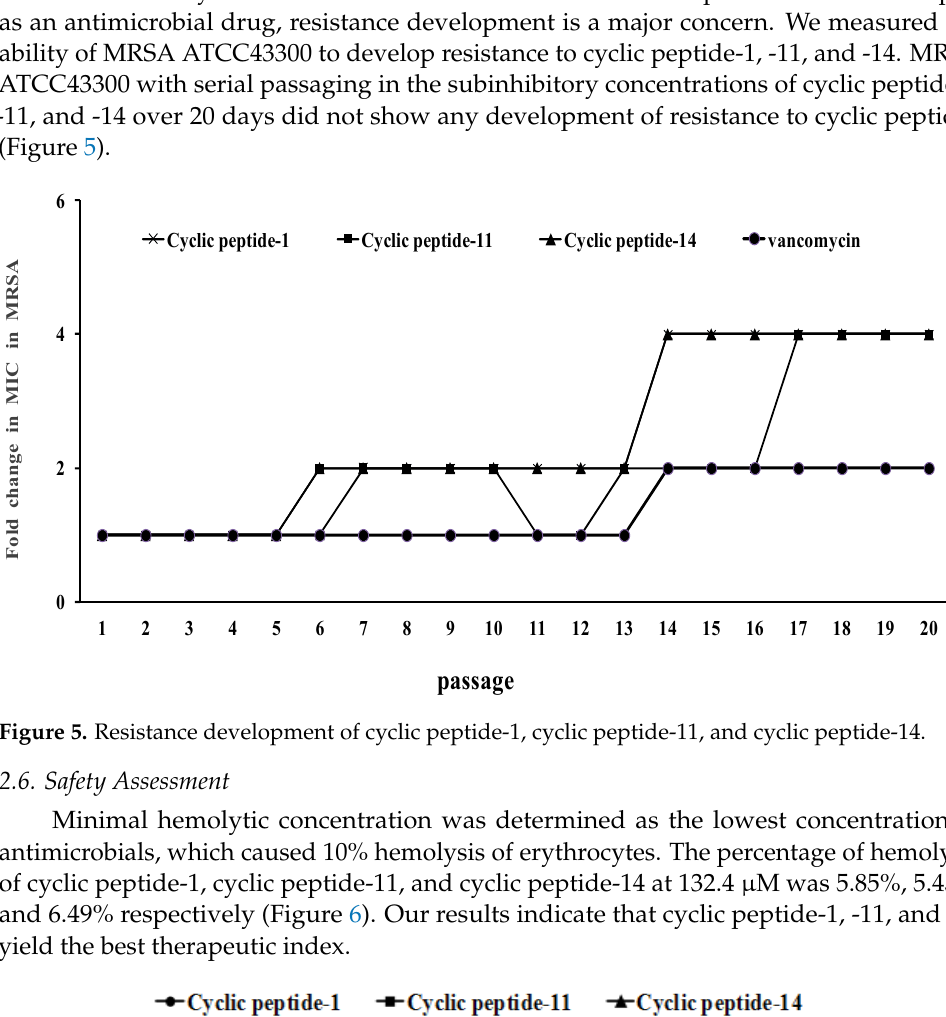
yield the best therapeutic index.